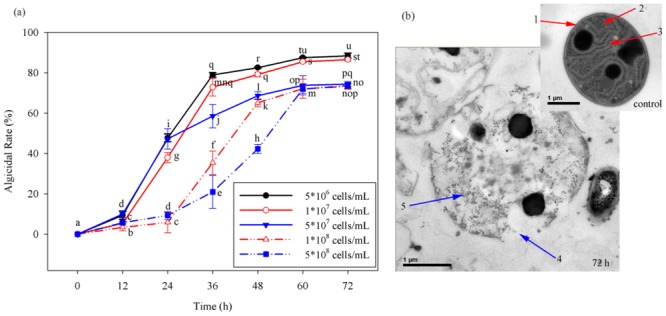
Algicidal characteristics of Alcaligenes aquatilis strain F8 against Microcystis aeruginosa.(a) Time course of algicidal characteristics of free strain F8. Data represent the mean of three independent experiments, with the SD indicated by an error bar. Different lowercase letters above the columns represent statistically significant differences in algicidal rate among treatment groups at different treatment times for strain F8 against M. aeruginosa (p < 0.05). (b) Transmission electron microscopy images of an untreated M. aeruginosa cell (shown as control) and a M. aeruginosa cell treated with strain F8 cell-free culture filtrate for 72 h (shown as treatment). Arrows indicate the following: 1: cell membrane; 2: photosynthetic lamellae; 3: cyanelle; 4: damaged cell membrane; 5: disordered cyanelle without photosynthetic lamellae to adhere to.